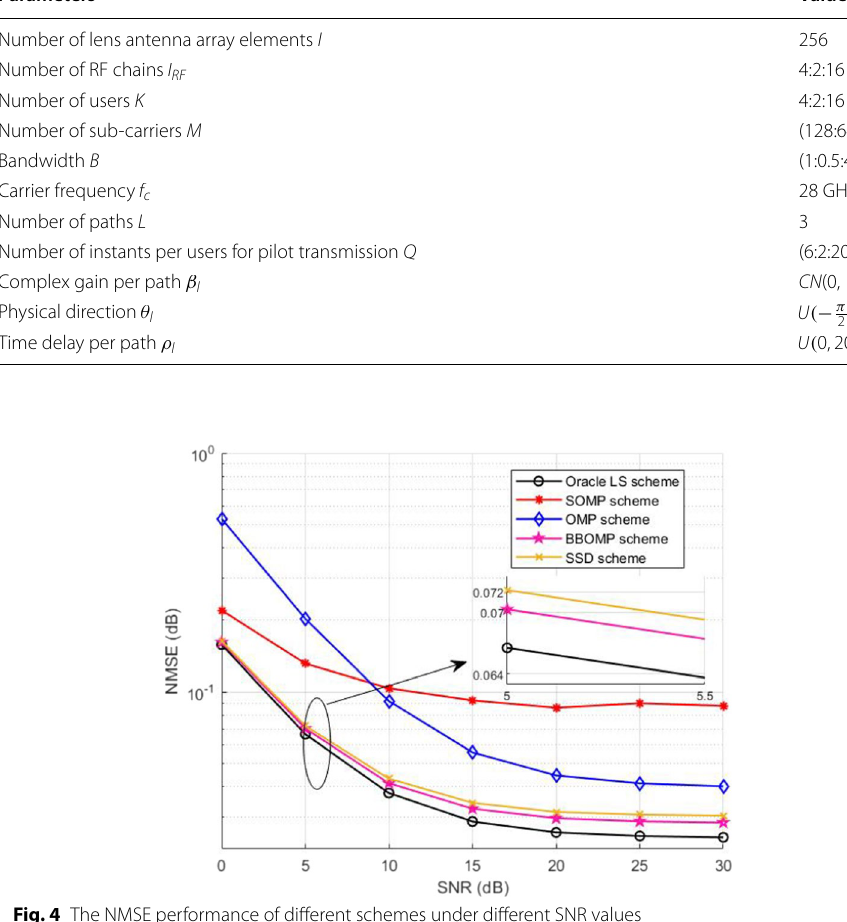
Table 2 System simulation parameters Parameters